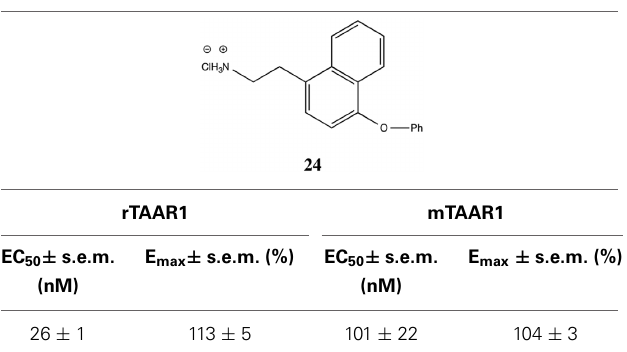
Table 4 | Activity of naphethylamine (derivative 24) on rTAAR1 and mTAAR1 (derived by Tan et al.,